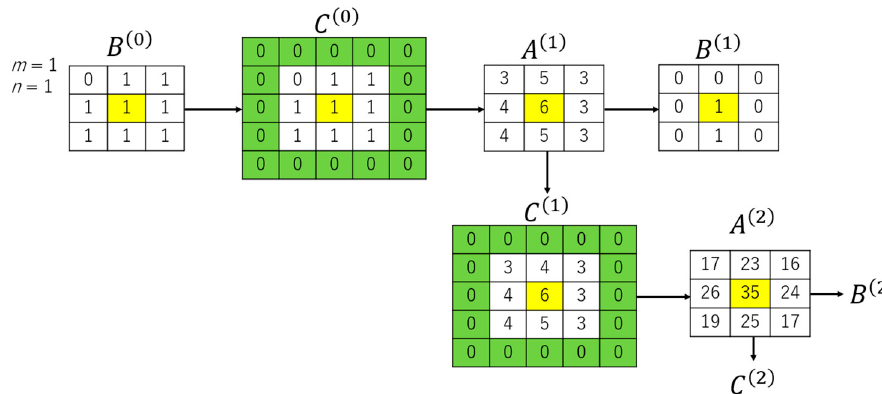
Figure 7. Pre-processing of binary images for DBC.